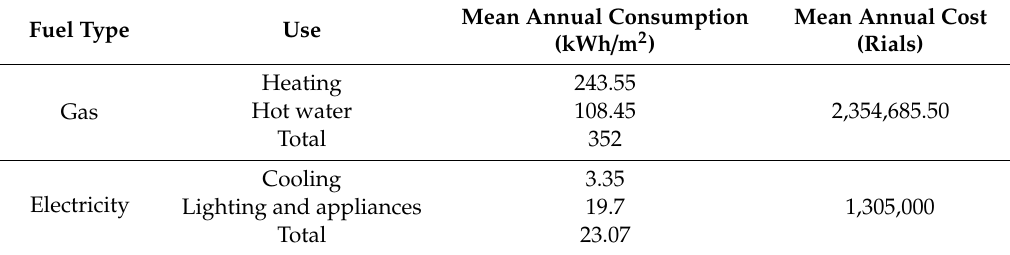
Table 4. Breakdown of the building energy